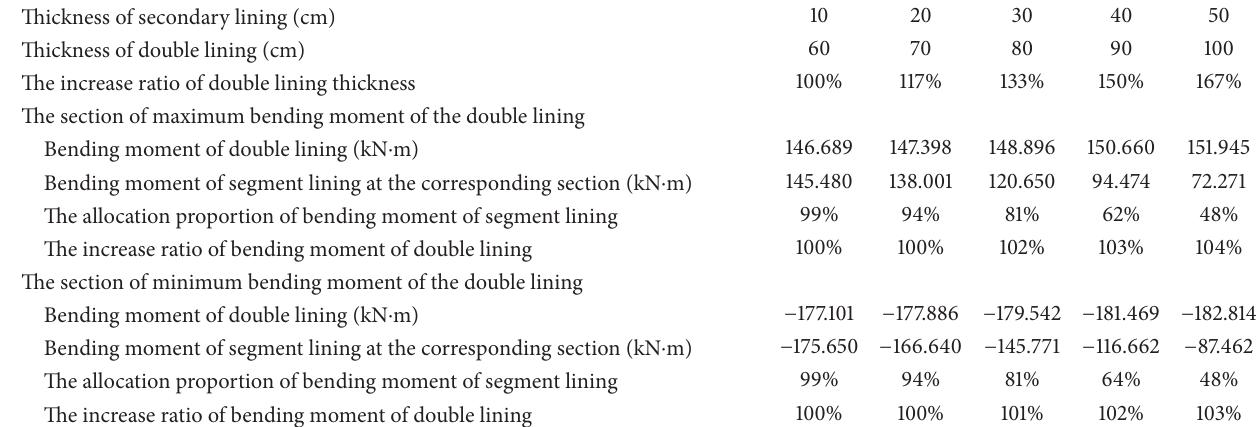
Table 8: The bending moments extreme values under different thicknesses of secondary lining.